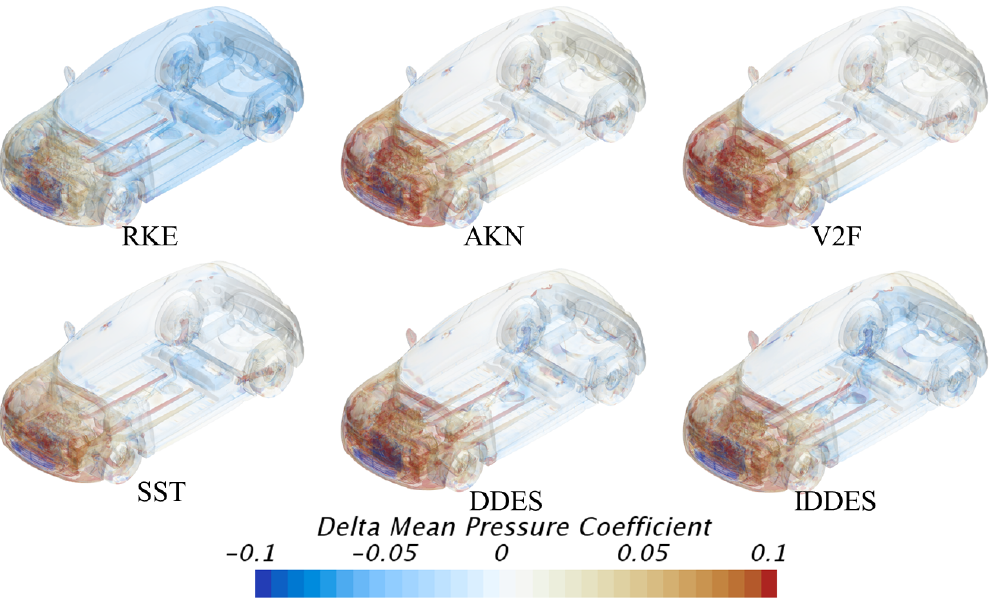
Figure 20. Delta pressure coefficient ( C P of Case 2 subtracted from C P of Case 1) distributions on the external surfaces of the